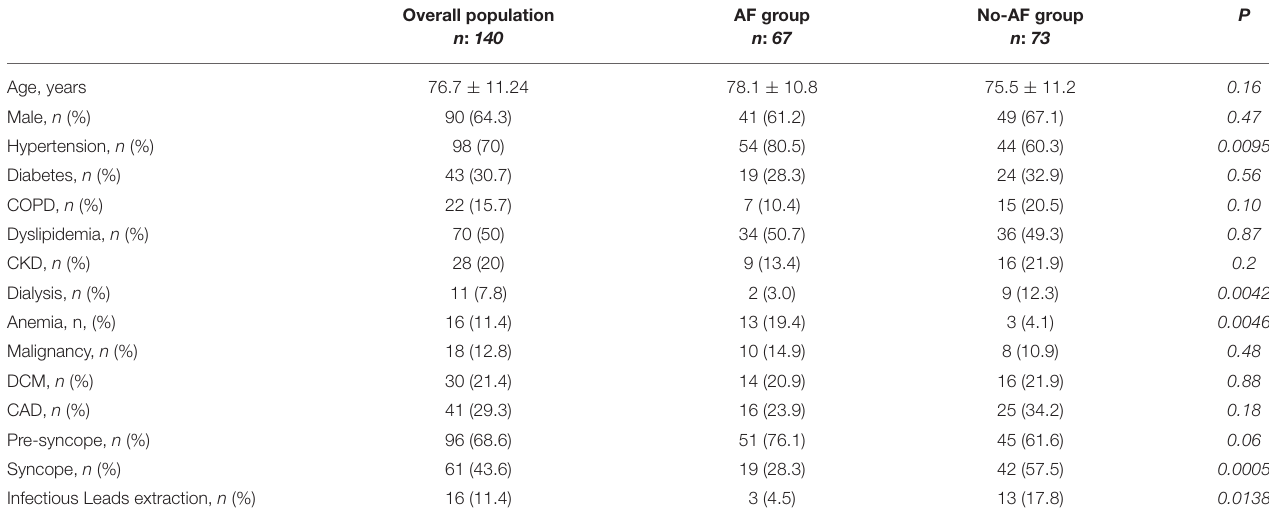
TABLE 1 | Baseline characteristics of study population.